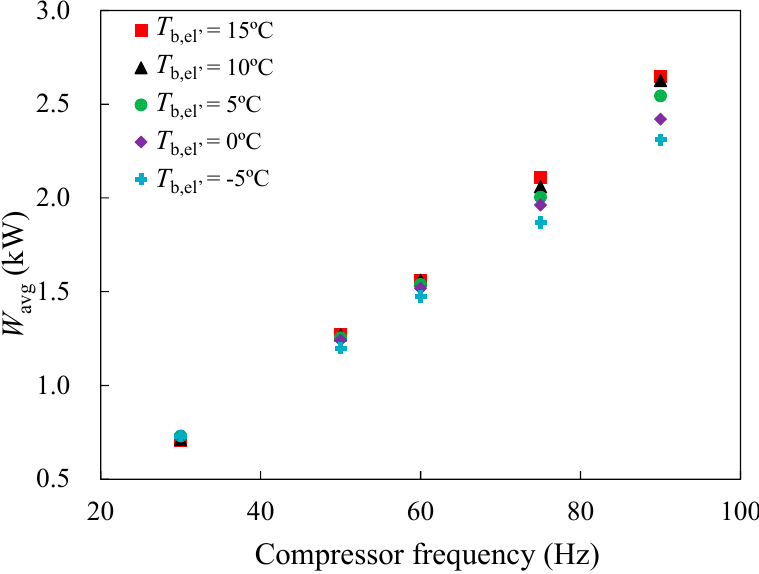
Figure 8. The power consumption W avg as a function of compressor frequency.